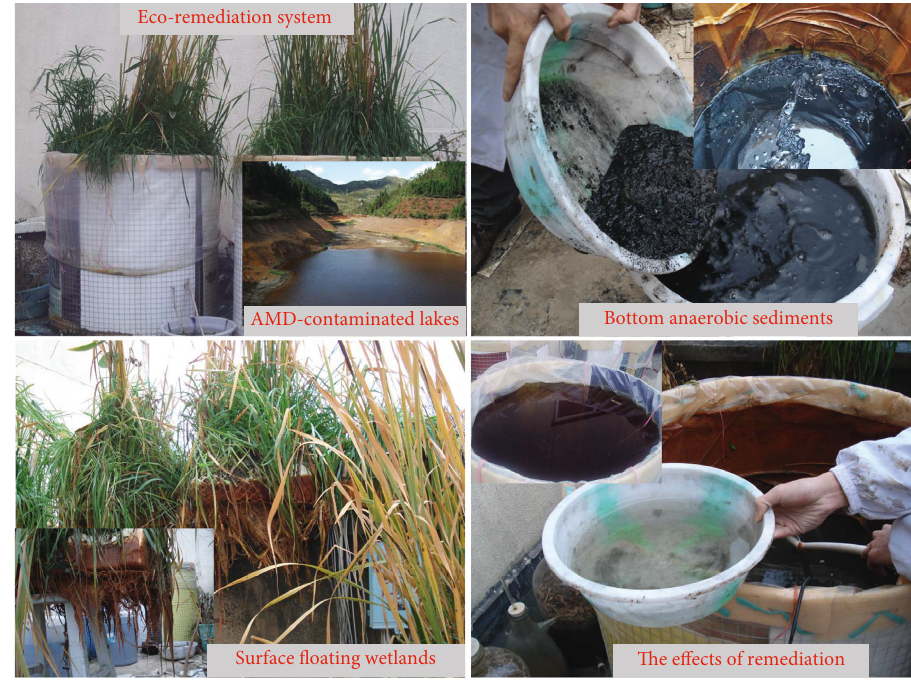
Figure 2: A pilot passive system for the remediation of an AMD-polluted ecosystem.